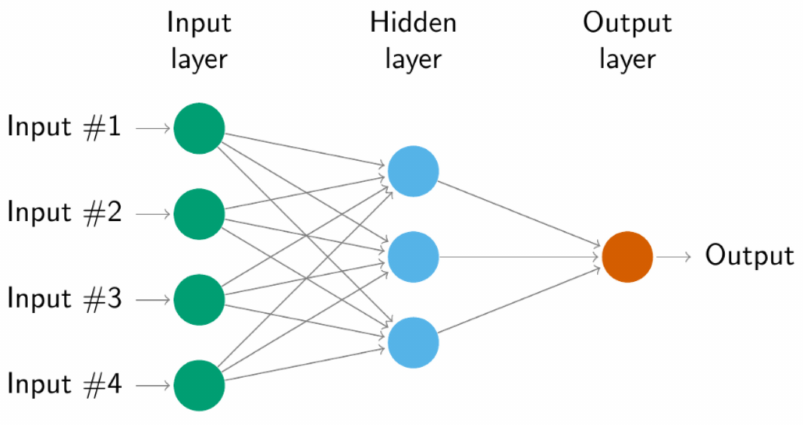
Figure 3. A diagrammatic representation of the NNAR (p, P, k)